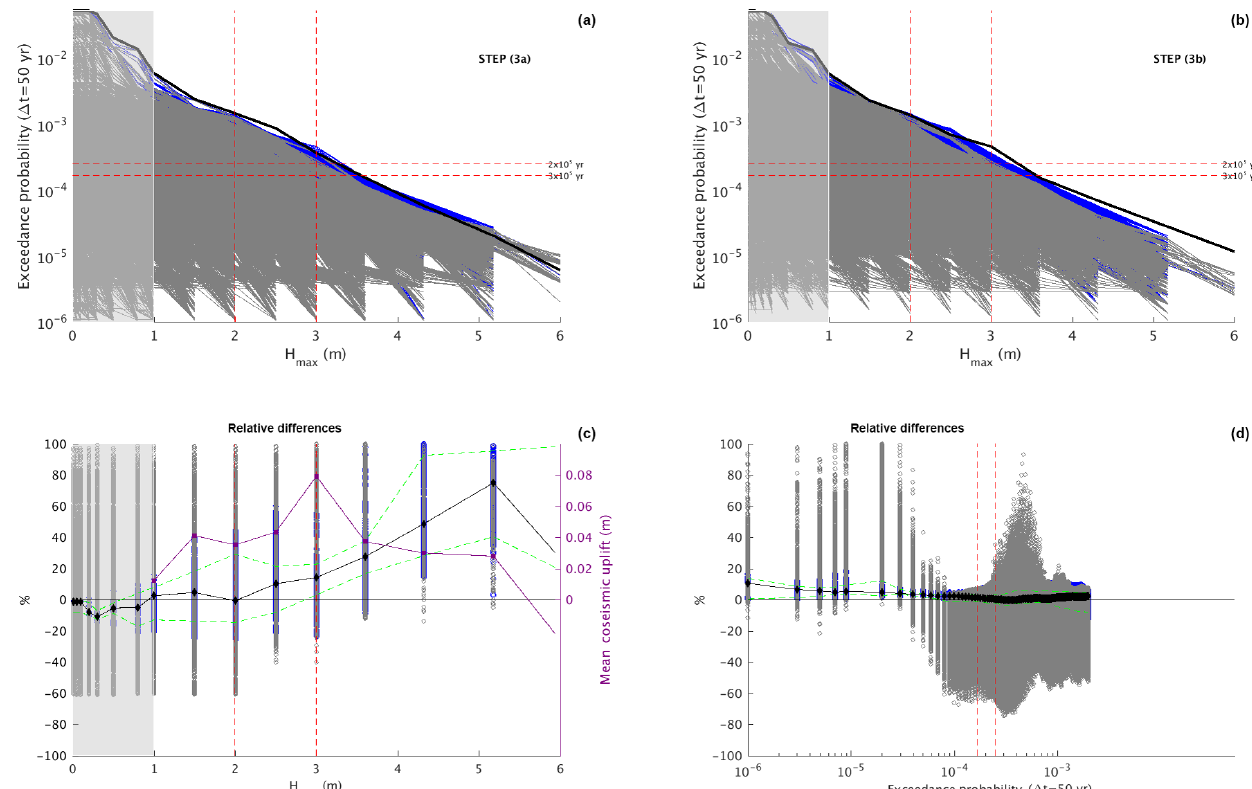
Figure 3. (a) Mean hazard curves for H max at all points within the highest-resolution grid, as obtained from step (3a) of the SPTHA procedure (see text and Fig. 1). Gray and blue colors refer to inland and offshore points, respectively. The bold black line represents the envelope of the curves from step (3b). Red dashed lines represent the values used to obtain probability (Fig. 4) and hazard (Fig. 5) inundation maps. (b) Same as (a) but using step (3b). The bold black line is the envelope of the curves from step (3a). (c) Relative differences in terms of exceedance probability (over 50 years) as a function of H max , computed as [ ( 3a ) − ( 3b ) ] /( 3b ) . The black line is the median of the point distribution; the green dashed lines correspond to the 16th and 84th percentile. The mean uplift (MU) on a random point along the coastline (see text) is also superimposed (purple line). (d) Same as (c) but in terms of H max as a function of the exceedance probability (over 50